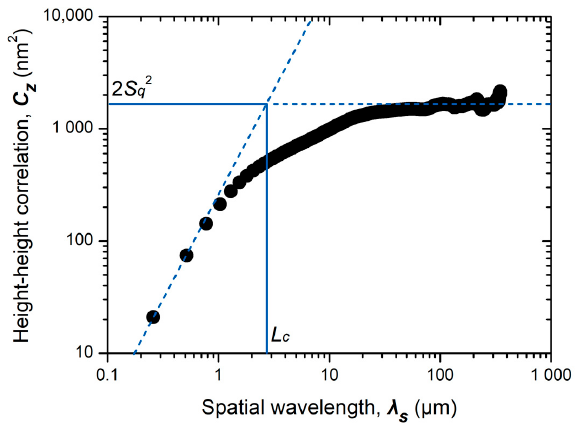
Figure 5. Determination of the root-mean-square (RMS) roughness ( S q ) and lateral correlation length ( L c ) using the height–height correlation function (HHCF).